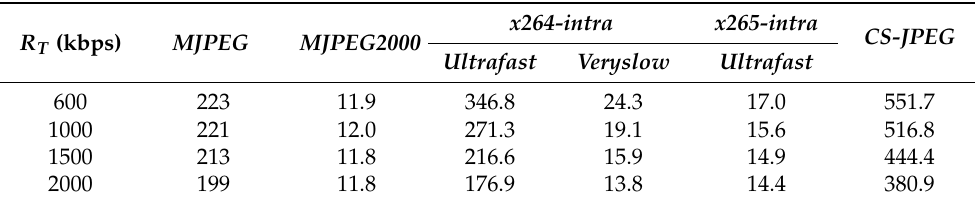
Table 5. Encoding speed in frames per second for ‘Foreman’ with 352 × 288 resolution and 300 frames on 2.8 GHz